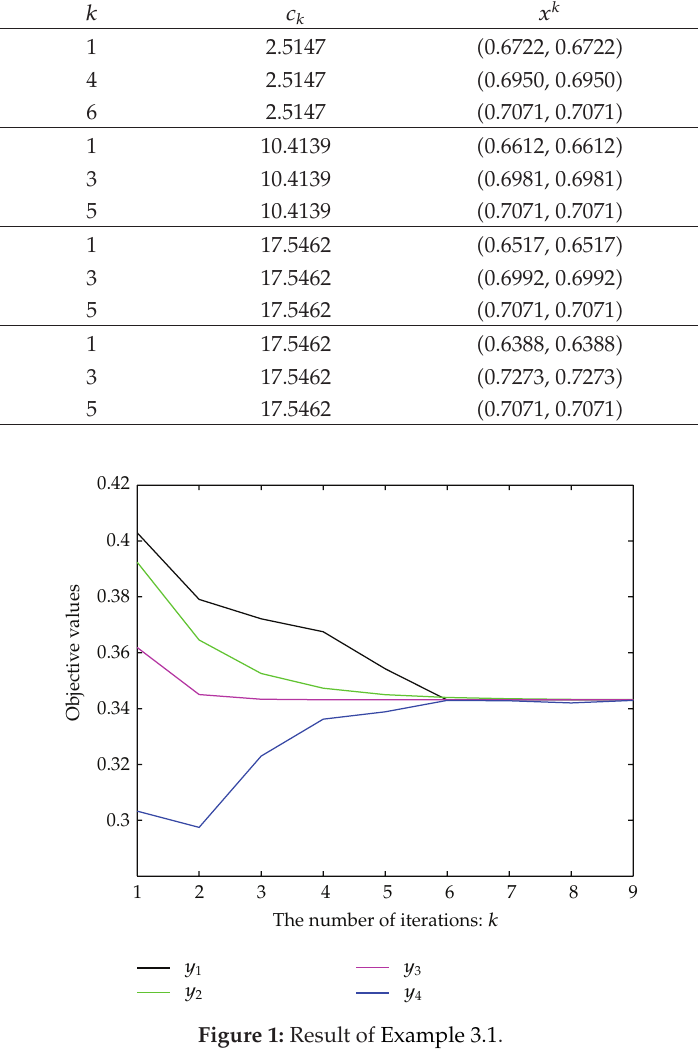
Table 1: Result of Example 3.1.